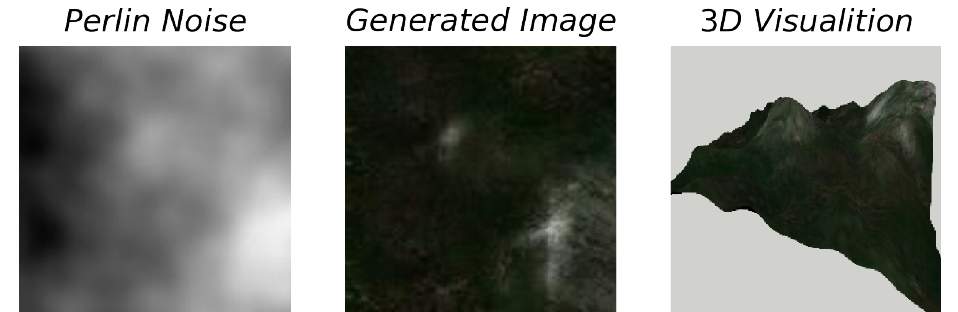
Figure 13. Given the inverse generator, G − 1 , a model that produces RGB coloration conditioned on a DEM, on can artificially and automatically create and render plausible 3D environments. More precisely, we sample a 256 × 256 DEM from a Perlin noise distribution [81], which is especially suited for generating plausible computer graphics imagery with peaks and valleys. By using this as input to the inverse generator, we are able to get a suitable coloration for it, yielding the above result. Provided this work does not study this problem, we have not optimized nor scrutinized the generator G − 1 and present the result in the interest of demonstrating its